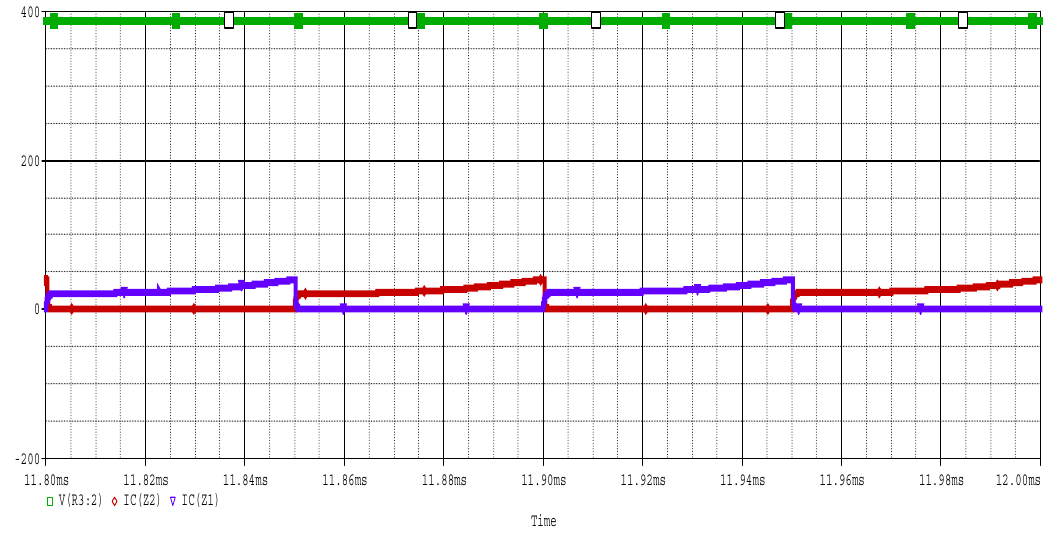
Figure 40. Full-load output voltage.